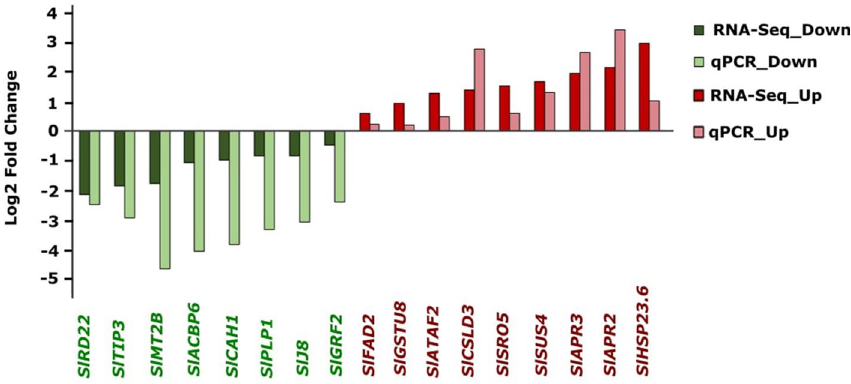
Figure 4. Validation of RNA-Seq data using qPCR. Log2 fold change in expression of 17 differentially regulated genes (Padj < 0.05) using RNA-Seq and qPCR (r = 0.87). Fold-changes represent the expression changes of each gene in response to SNP-treatment relative to the untreated control (n = 3).